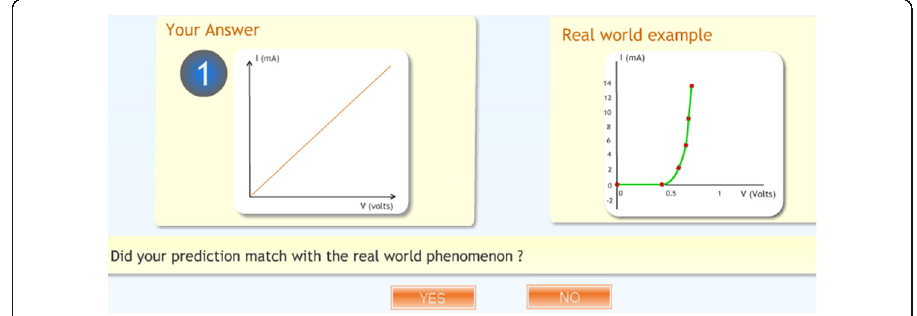
Fig. 6 Real-world answer for comparison and